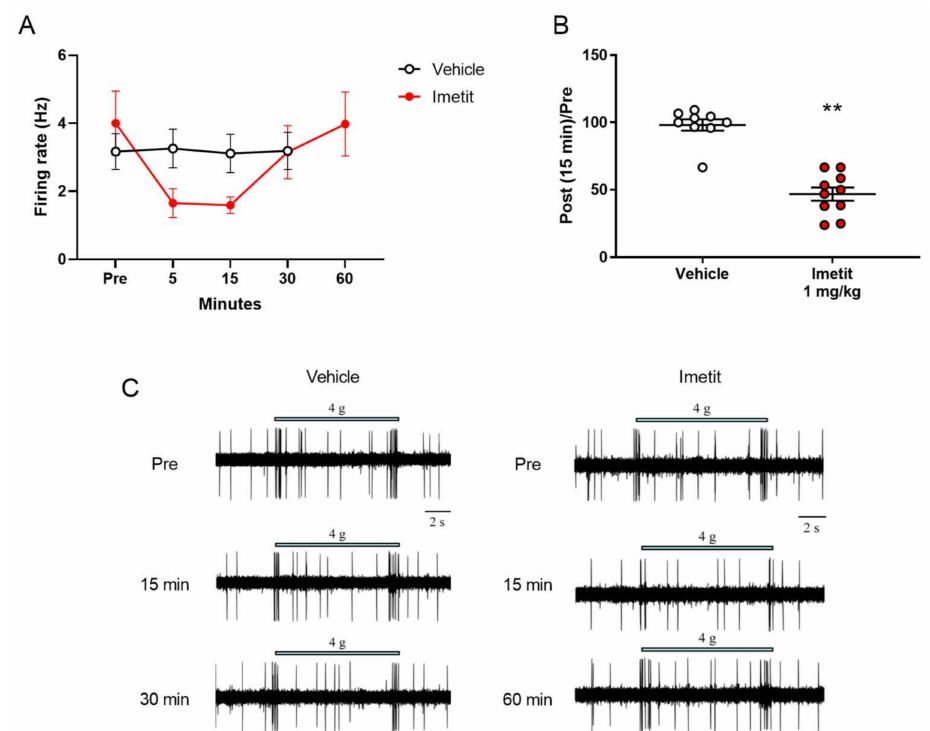
Figure 3. Imetit (1.0 mg/kg) suppressed penile mechanical stimuli-evoked firing of the spinal dorsal horn. The genital area was stimulated with a von Frey filament (vFF), following which we evaluated evoked firing: ( A ) temporal changes in the firing rate, ( B ) post and pre-administration ratios, ( C ) representative trace of vFF-evoked firing recorded from the vehicle or imetit group. Data are presented as the mean ± S.E.M. ** p < 0.01 vs. vehicle group analyzed using Student’s t -test (n = 9–10).